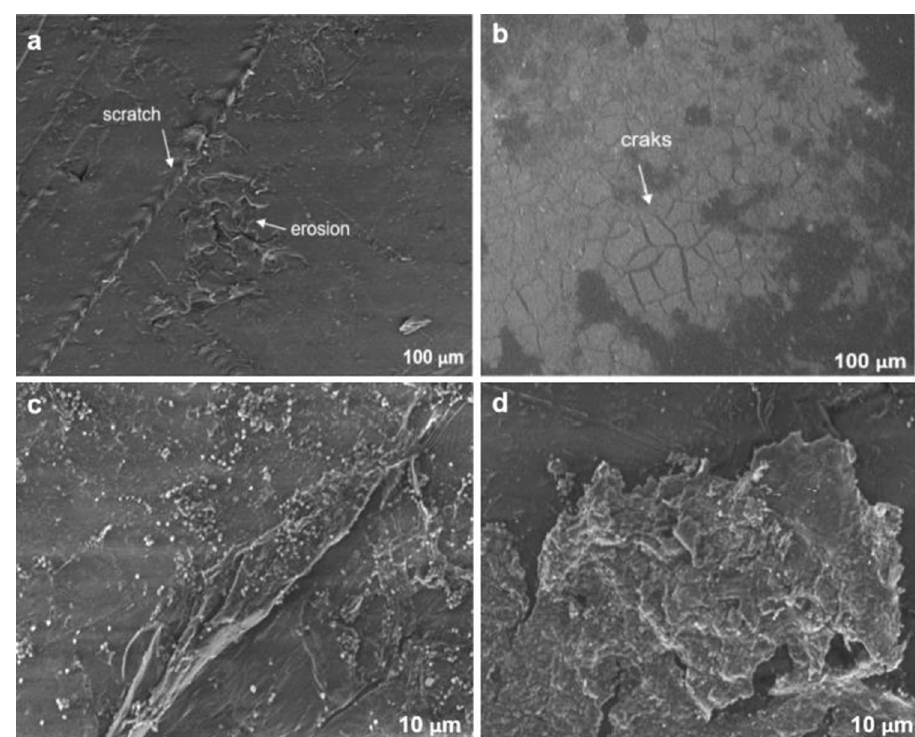
Fig. 6 Scanning Electron Microscopy. a samples of aged LDPE composted during 61 days; b samples of aged LDPE composted during 91 days; c and d: samples of aged LDPE composted during 124